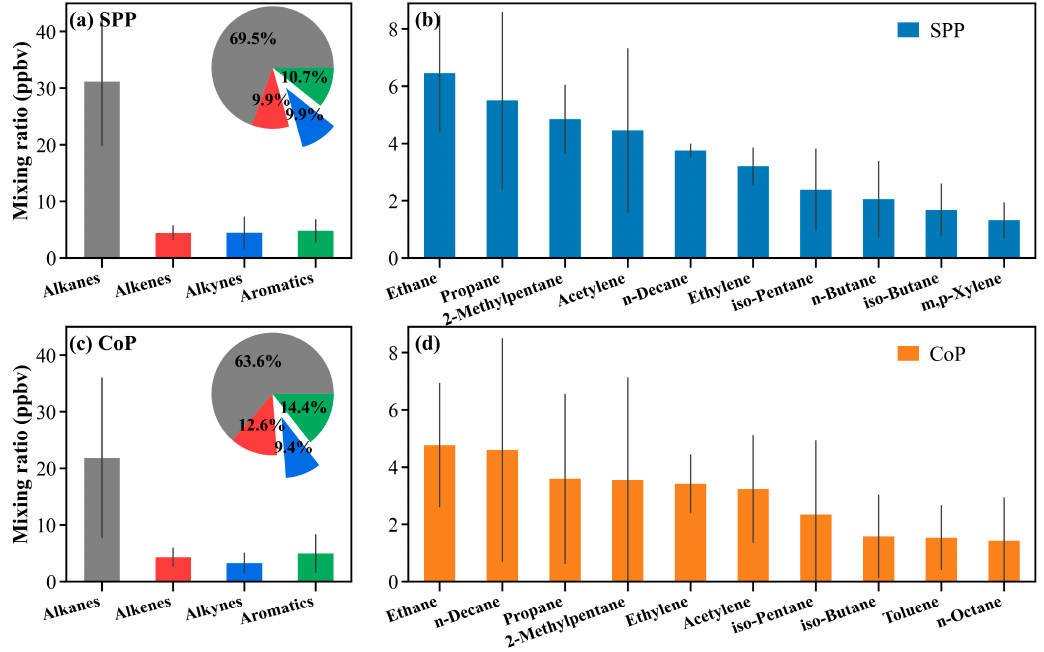
Figure 6. The VOC composition ( a , c ) and top 10 abundant species ( b , d ) in different pollution epi- sodes. The error line on each bar corresponds to the standard